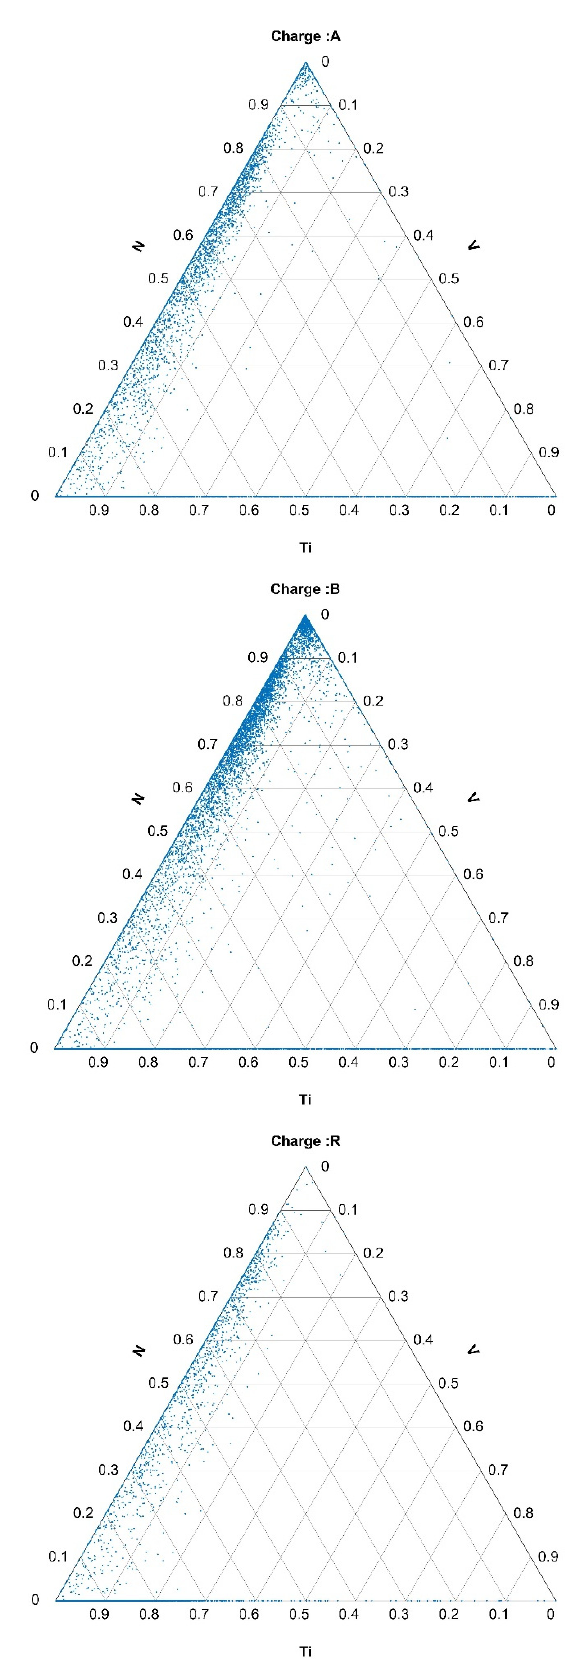
Figure 6. Composition of Ti-, V-, and N-containing inclusions in hot-rolled plates of Ti-stabilized Cr-Ni-Mo steel A, B, and R.